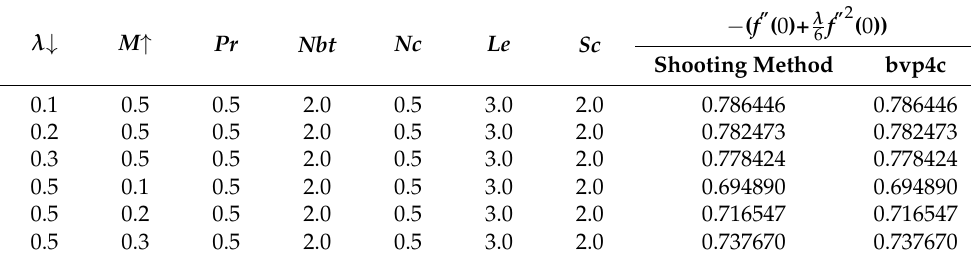
Table 1. Effect of physical parameters on the skin friction coefficient.